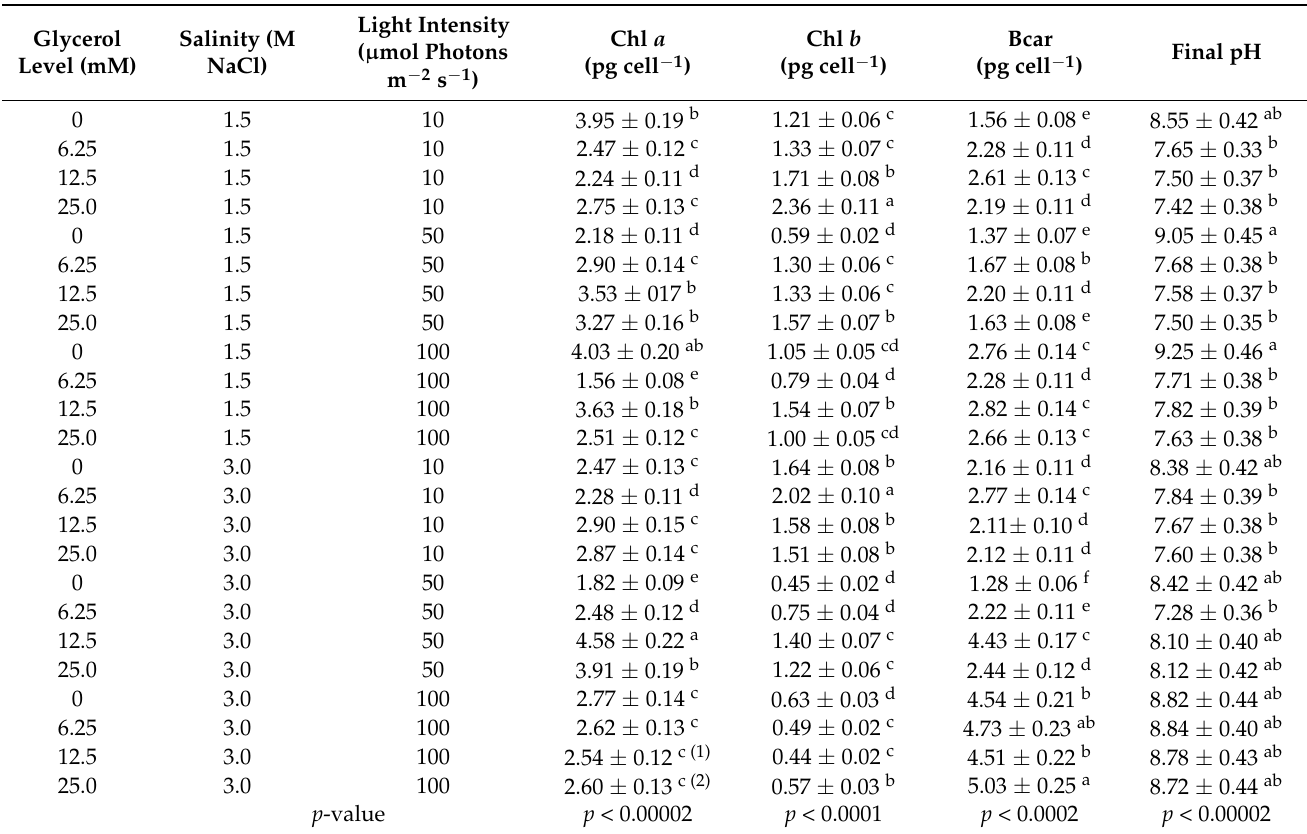
Figure 2. Cell density of D . salina cultured with different combinations of glycerol, salinity, and light intensity. The following interaction is indicated: glycerol, 0 mM ( a ), 6.25 mM ( b ), 12.5 mM ( c ) and 25 mM ( d ) with 1.5 and 3.0 M NaCl as well as with 10, 50 and 100 µ mol photons m − 2 s − 1 respectively. Values correspond to the mean ± standard deviation of three replicates. Table 2. Chl a , Chl b , BCar, and culture pH of D . salina grown under different levels of glycerol, non-isosmotic salinity, and light intensity. The initial pH range was 6.20–6.35, and the final pH corresponds to the 7th day of cultivation. Values in the same columns with different superscript are significantly different.